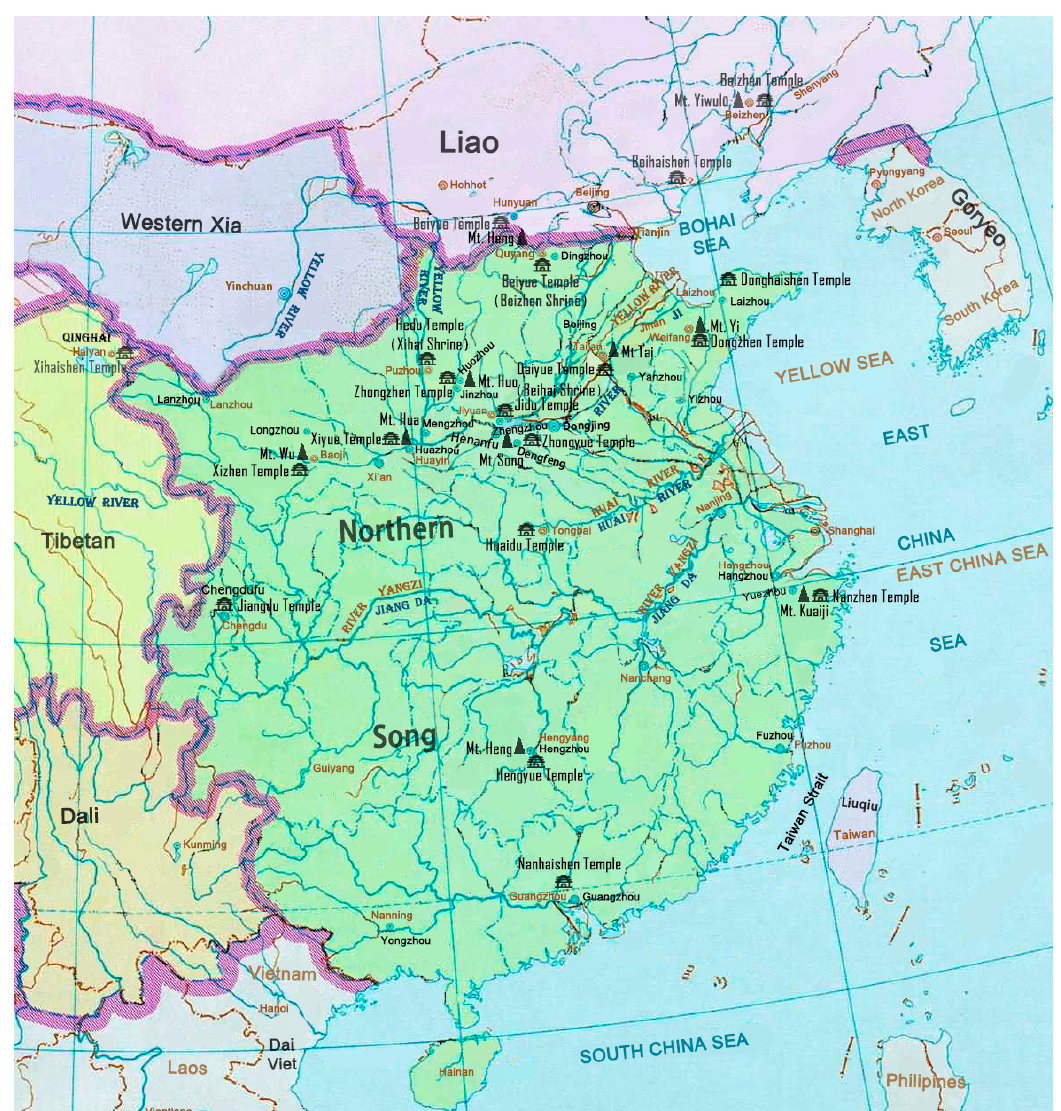
Figure 1. Temples of the five sacred peaks, five strongholds, four seas, and four waterways in the Northern Song (The Northern Song map is based on Tan 1982–1987, v.